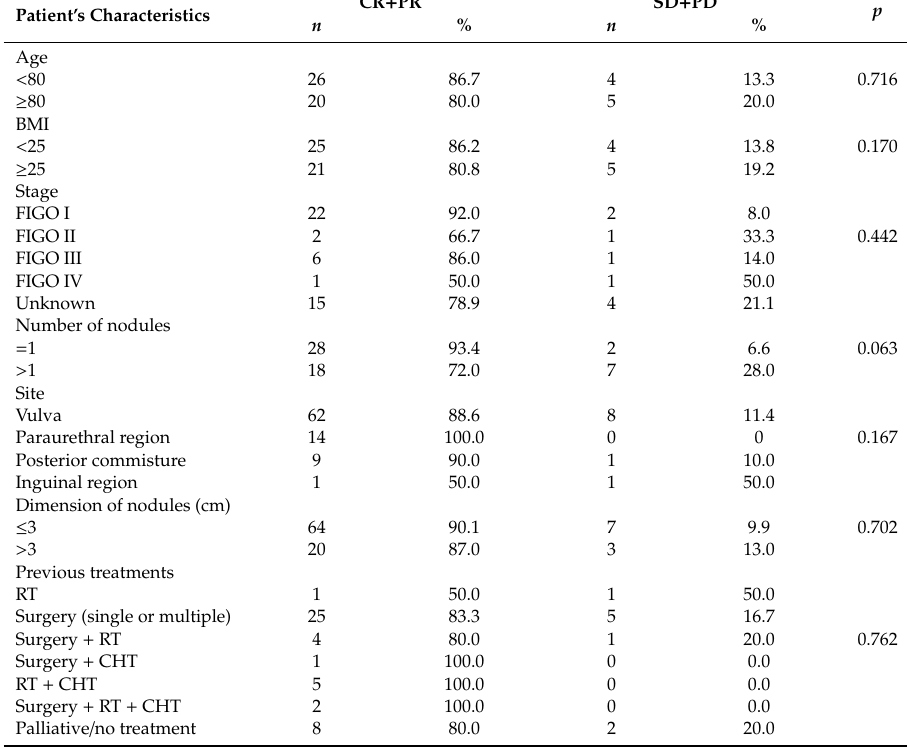
Table 1. Correlation between response to ECT according to di ff erent covariates: age; BMI; stage of disease; number, site and dimension of nodules; and previous treatments. CR = complete response; PR = partialresponse; SD = stabledisease; PD = progressiondisease; RT = radiotherapy; CHT = chemotherapy. Patient’s